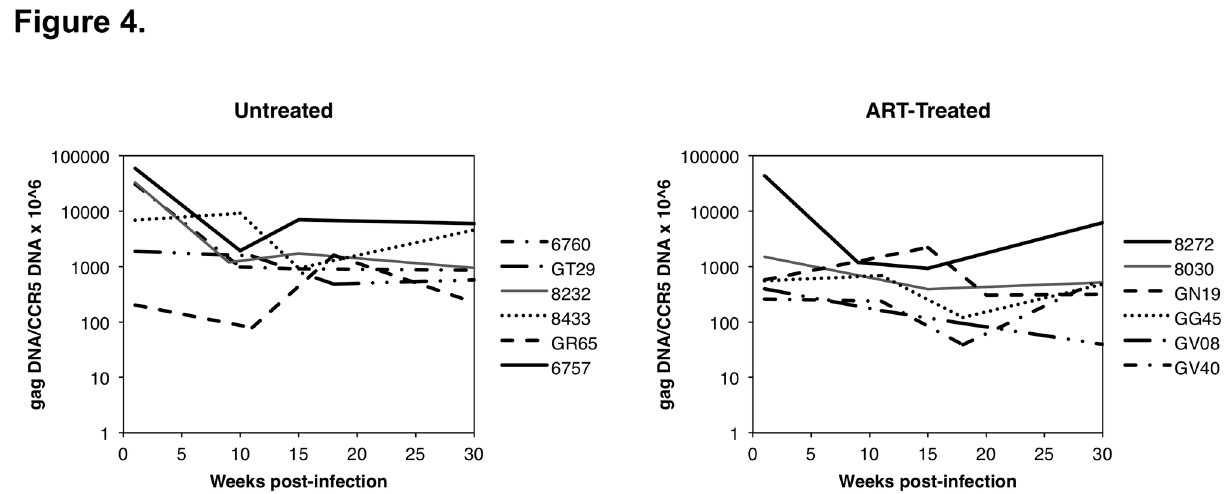
Figure 4. The ratio of RT-SHIV gag DNA copies per 10 6 macaque CCR5 DNA copies were measured in PBMC isolated at different time points from each of the untreated and treated macaques.